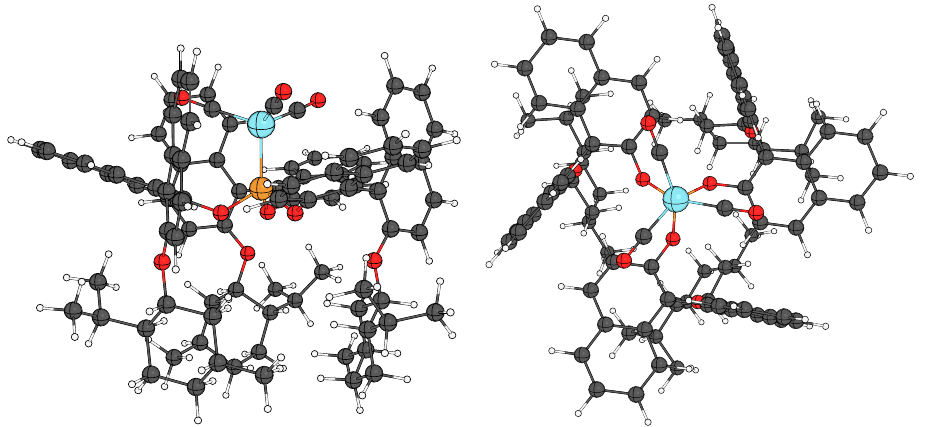
Figure 4. Side and top view of nickel tricarbonyl complex Ni(CO) 3 L1 , used for the calculation of the computed steric and electronic parameters of monophosphite ligand L1 (blue = Ni; orange = P; red: O; black = C; white = H).